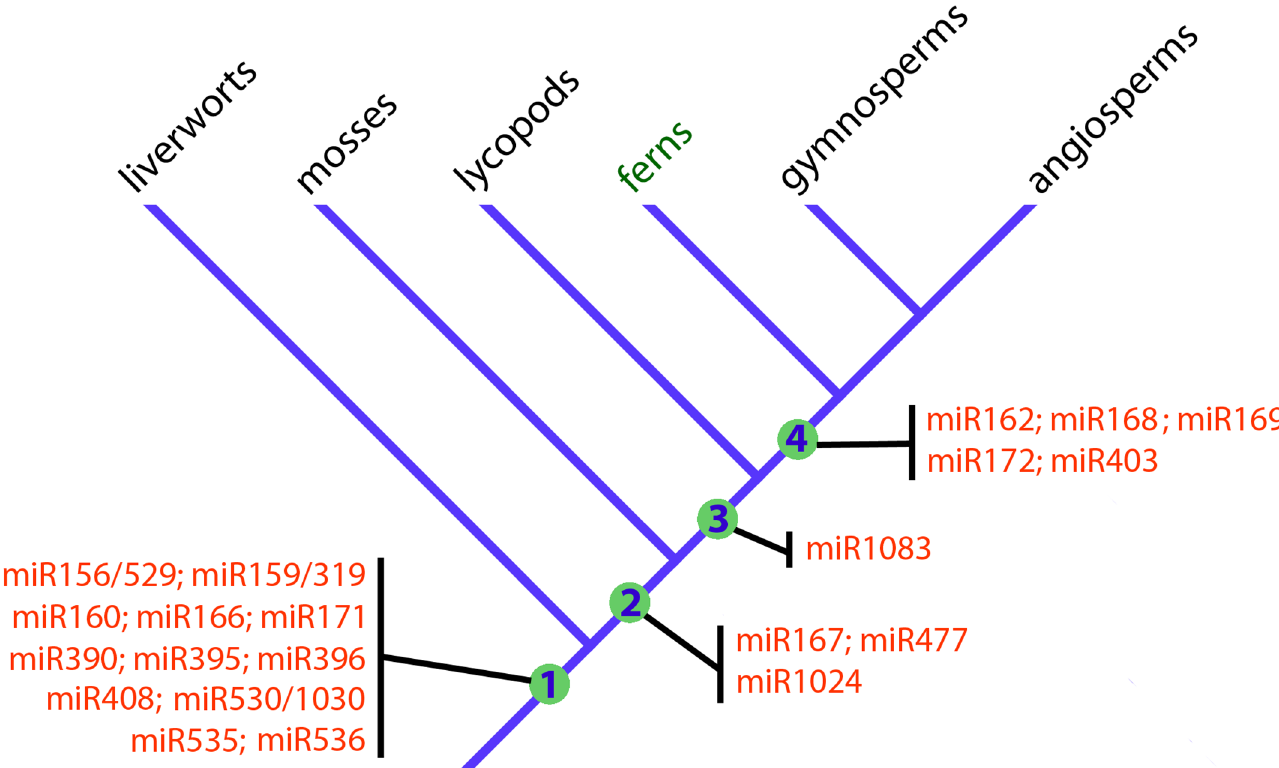
Fig 6. Emergence of miRNAs during early land plant evolution. The schematic cladogramshows the origin of ancient miRNA families during early land plant evolution.Only miRNA families that originatedin early landplant evolutionare shown, namely land plants (Embryophyta, node 1), mosses and vascular plants (node 2), vascular plants (Tracheophyta, node 3) and ferns and seed plants (Euphyllophyta, node 4). Note that, accordingto recent molecularphylogenies [25, 26], liverworts and mosses might belongtogetherin a clade that is sister to vascular plants, in which case nodes1 and 2 would be the same. Also note that five miRNA families seem to be restricted to euphyllophytes and that only miR1083seems to have originatedin the branch leadingto vascular plants.